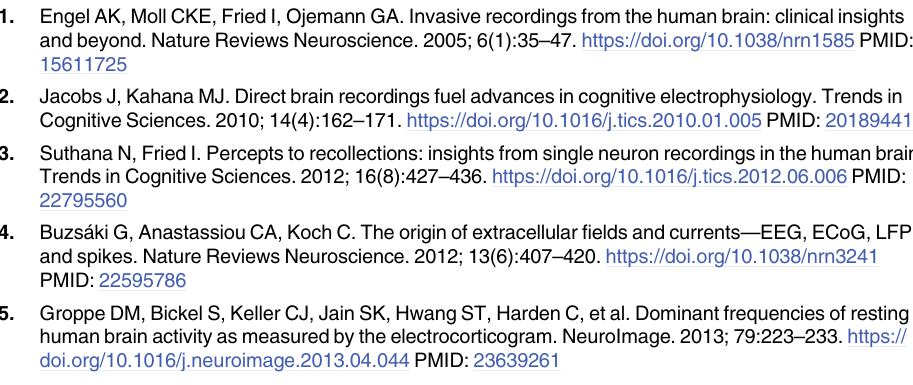
electrodes are shown, for the common average reference row the center electrodes are shown. For SSD spatial patterns and spatial filters see Fig 2. (TIF) S2 Fig. SSD spatial filters preserve task-related dynamics. A) Hand-movement trials for the SSD component with highest SNR, with detected burst in the mu-rhythm frequency range highlighted. The event-related desynchronization in the post-cue period is high for hand movements, no desynchronization can be seen for tongue movements, as seen in B). C) The same dynamic can be seen for common average referenced signal for hand movement trials, and tongue movment trials in D). The same burst detection criteria were applied for both referencing methods.